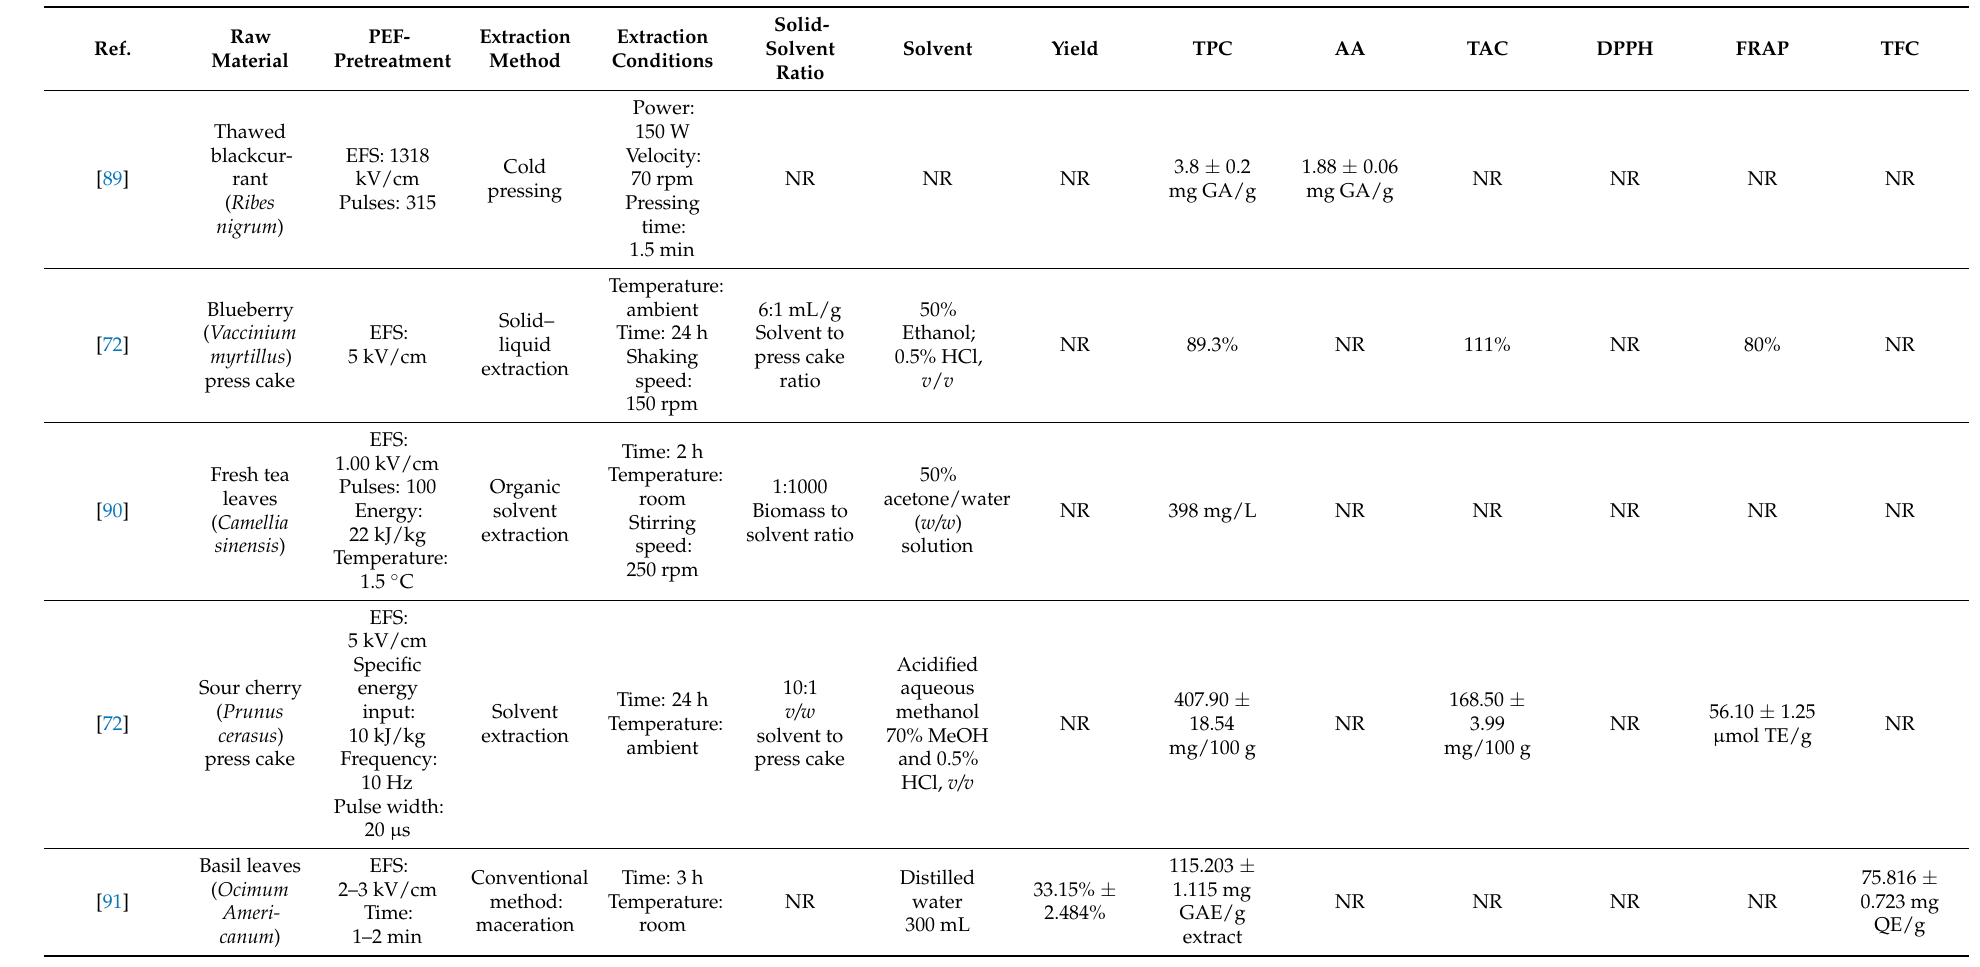
Table 2. The extraction of bioactive compounds assisted by PEF